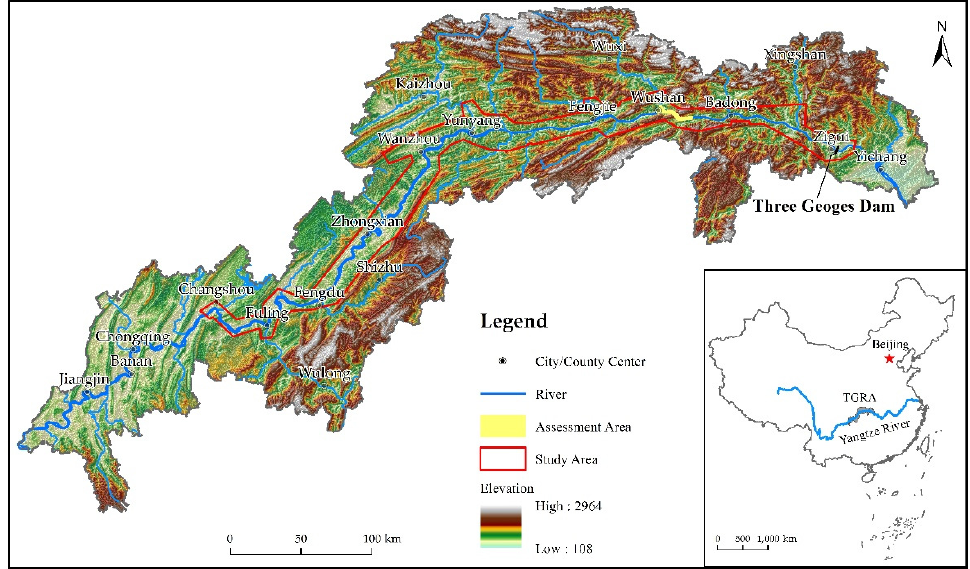
Figure 1. Location map of the study area and the Three Gorges Reservoir Area (TGRA). Data acquisition and processing were conducted in the whole study area, while the landslide detection ability assessment was conducted in the assessment area.